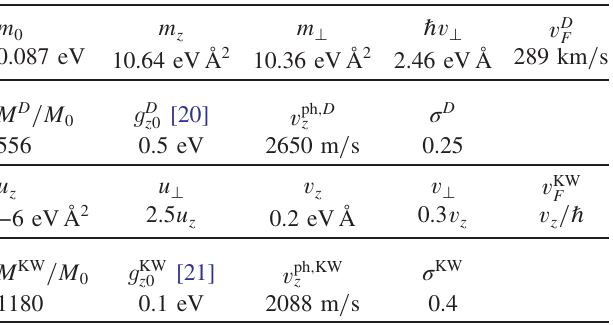
TABLE II. Model parameters for Dirac (Na 3 Bi) [16] and Kramers-Weyl ( β -Ag 2 Se) [19] semimetals. The relative atomic mass M 0 ¼ 1 . 661 × 10 − 27 kg and Land´e g factor is set as 2. The superscript D (KW) in the symbols stands for Dirac (Kramers- Weyl) semimetals, while the subscript F stands for Fermi.